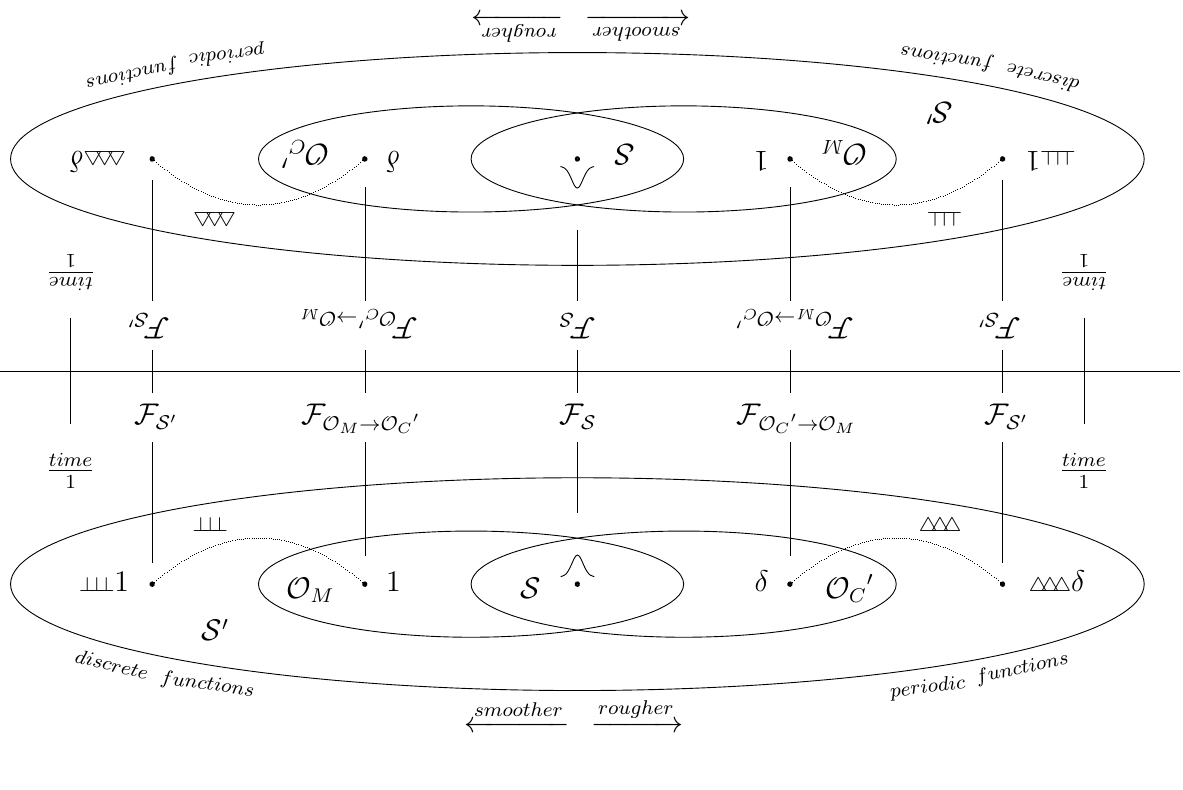
Figure 4. The space of tempered distributions and important